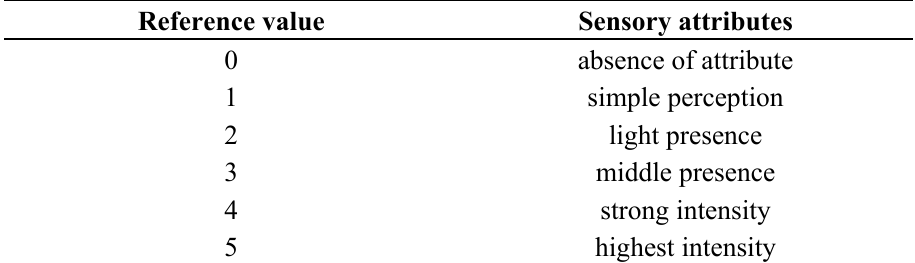
Table 3. Values of the six points adopted by the panel (Note: with permission from [115], Copyright © American Chemical Society,